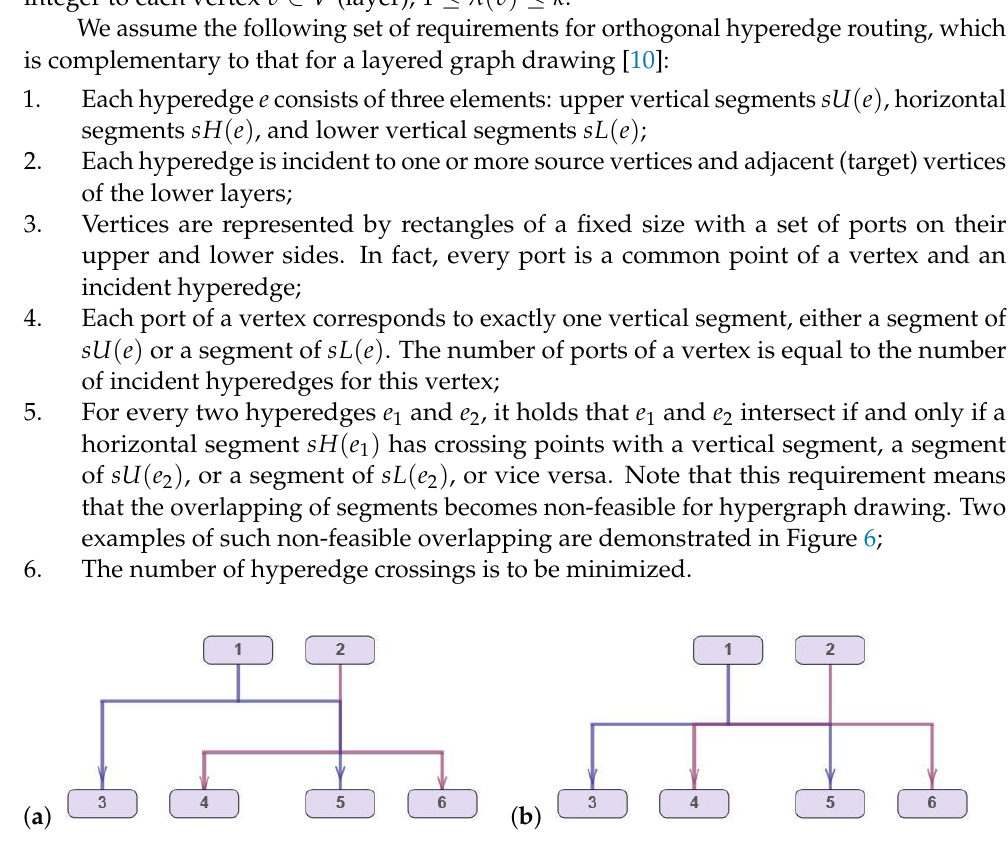
Figure 6. Examples of the non-feasible overlapping of hyperedges: ( a ) non-feasible overlapping of vertical segments; ( b ) non-feasible overlapping of horizontal